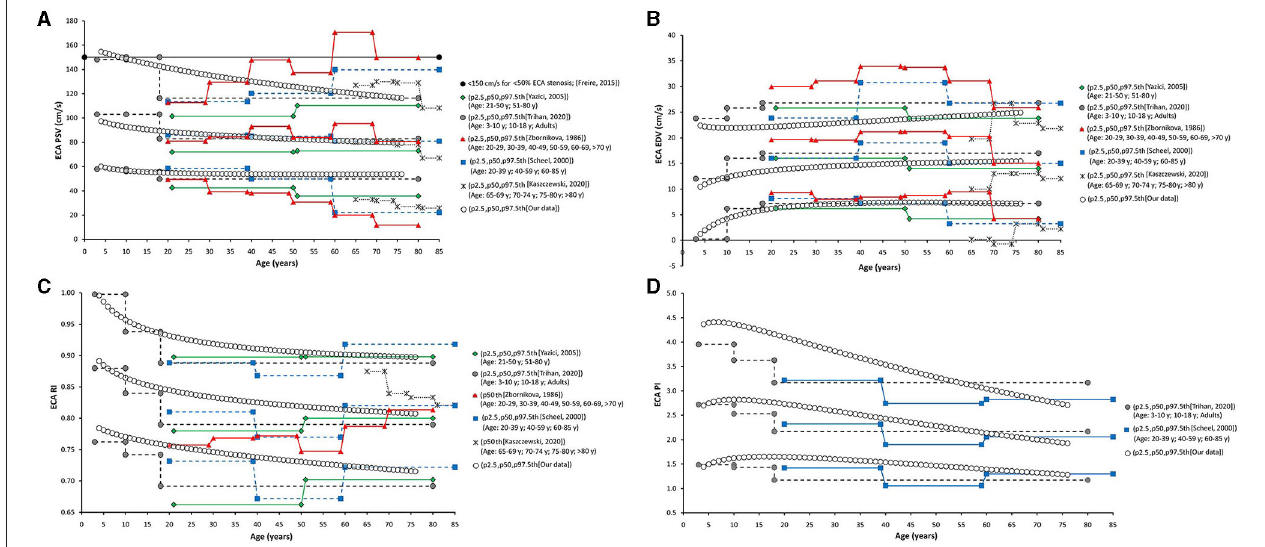
FIGURE 9 | External carotid artery. Comparison among curves of PSV (A) , EDV (B) , RI (C) , and PI (D) , obtained in our study (2.5th, 50th, and p97.5th percentiles) and mean values (p50th), and 2.5th (MV–1.96 × SD) and 97.5 (MV + 1.96 × SD) percentiles obtained by other authors when studying groups of subjects of different ages. The fixed cut-off levels used to identify (graduate) levels of arterial stenosis are also